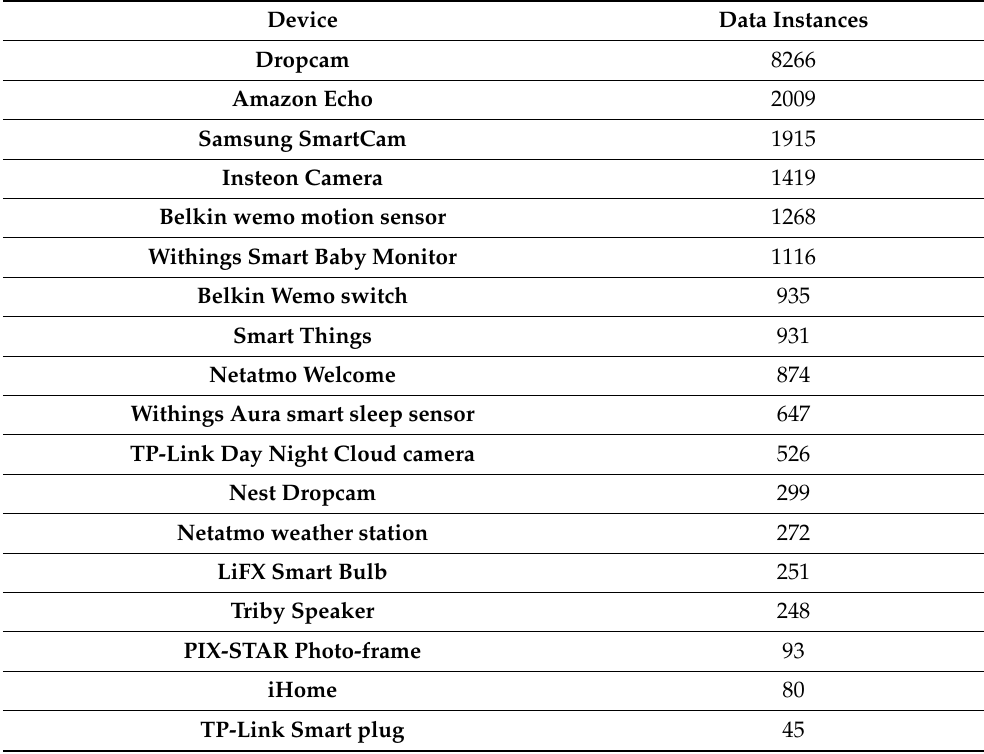
Table 5. Statistics about the number of data instances for each